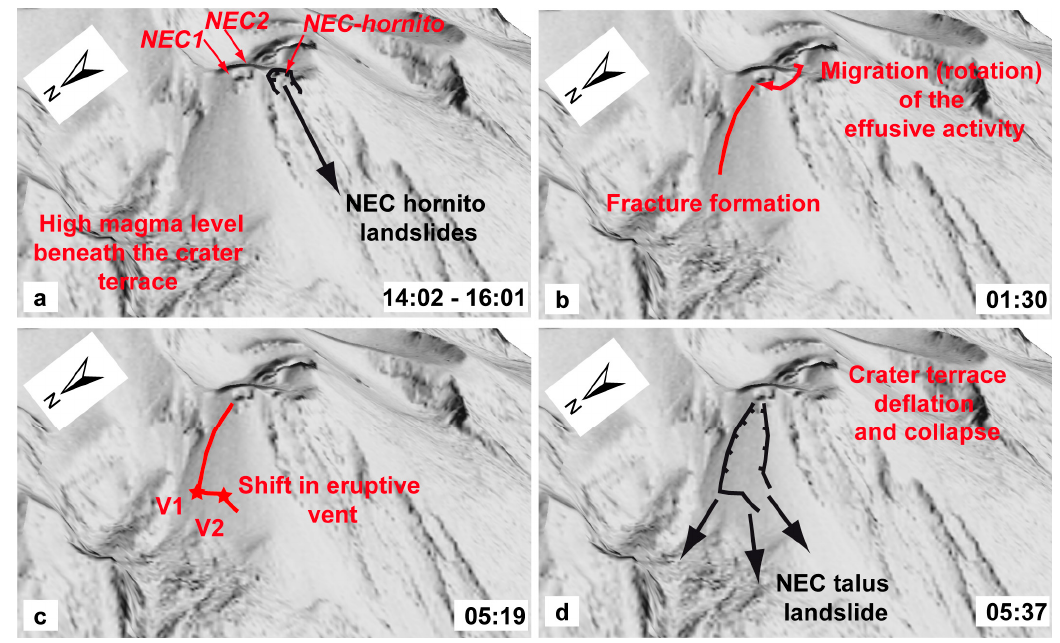
Figure 10. Schematic sketches representing the onset of the 2014 flank eruption as reconstructed on the basis of the new data presented in this paper. ( a ) The run-up phase of the 2014 flank eruption was characterized by high magma level beneath the crater terrace, which peaked on 6 August 2014 morning, with the occurrence of a large overflow from the NEC-hornito, triggering its collapse. Then the activity migrated from the NEC-hornito towards the NEC1. ( b ) The onset of the eruption coincided with the lateral dike propagation from the crater terrace along a NE-SW direction, triggering the instability of the NEC-talus, as evidenced by the increase in displacement rate at NEC-talus (until the loss of coherence in the GBInSAR data, compare with Figure 5) and landslides number (Figure 7). ( c ) Then the shift in the effusive vent from V1 to V2 occurred, ( d ) closely related to the NEC-talus collapse. Magmatic and mass-wasting phenomena are represented in red and in black, respectively.